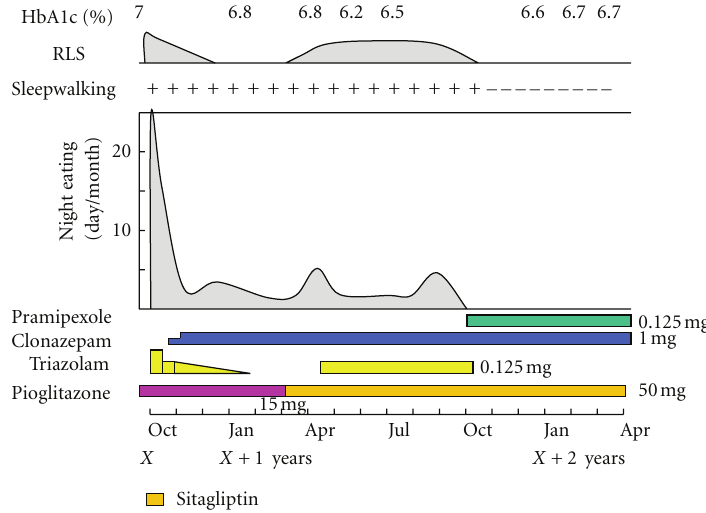
Figure 1: Clinical course. Reduction in the dose of triazolam decreased the freque006Ecy of night eating. Night eating was reduced by stepwise addition of clonazepam and pramipexole. RLS: restless legs syndrome; Sleepwalking +: present; Sleepwalking − : absent; X year presents the year at first